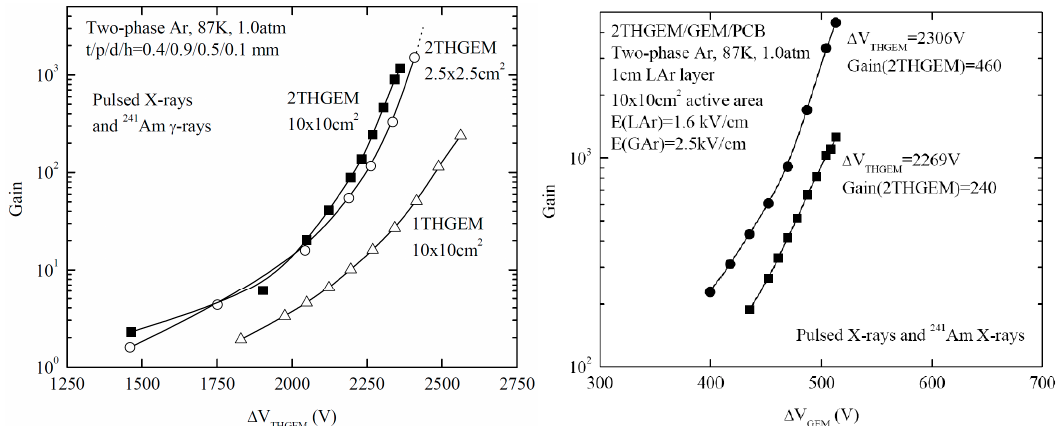
Figure 19. Left: gain characteristic of double-THGEM multipliers in a two-phase Ar detector for a THGEM active area of 10 × 10 cm 2 (maximum gain was limited by discharges) compared to that of 2.5 × 2.5 cm 2 (maximum gain was not reached) [72]; a comparison to that of a single-THGEM multiplier (maximum gain was limited by discharges) is also shown. Right: gain characteristics of hybrid 3-stage 2THGEM/GEM multiplier in two-phase Ar detector for active area of 10 × 10 cm 2 [4,72]. Shown is the overall multiplier gain as a function of the voltage across GEM, at two fixed voltages across each THGEM, i.e., at two values of 2THGEM gain indicated in the figure. Here the maximum gains were limited by discharges.